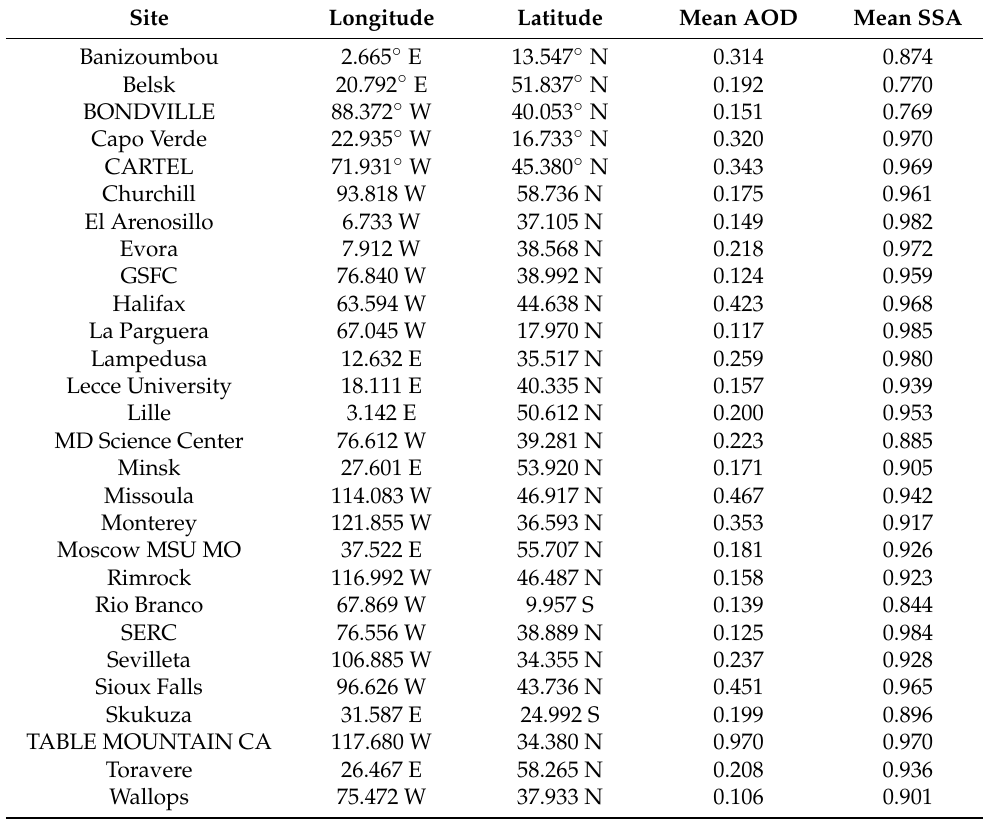
Table 1. Geographic location and annual mean aerosol parameters of AERONET sites.